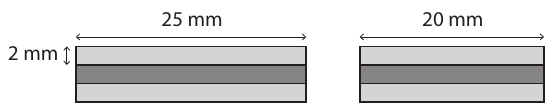
Figure 3. Rectangular joints manufactured.